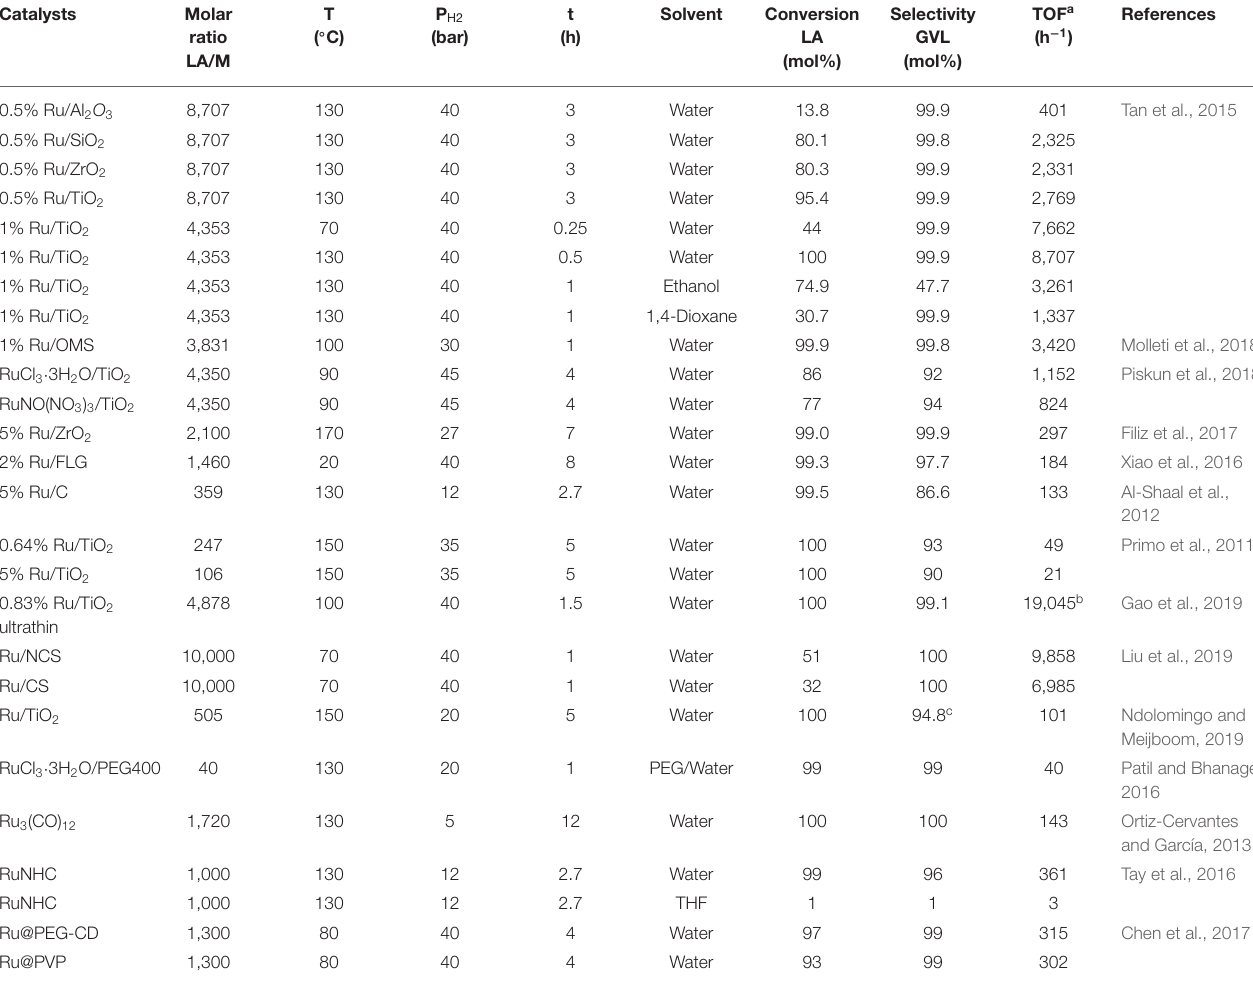
TABLE 1 | Ruthenium-based heterogeneous catalysts on solid supports and water-dispersible catalytic nanoparticles for the hydrogenation of LA toward GVL.